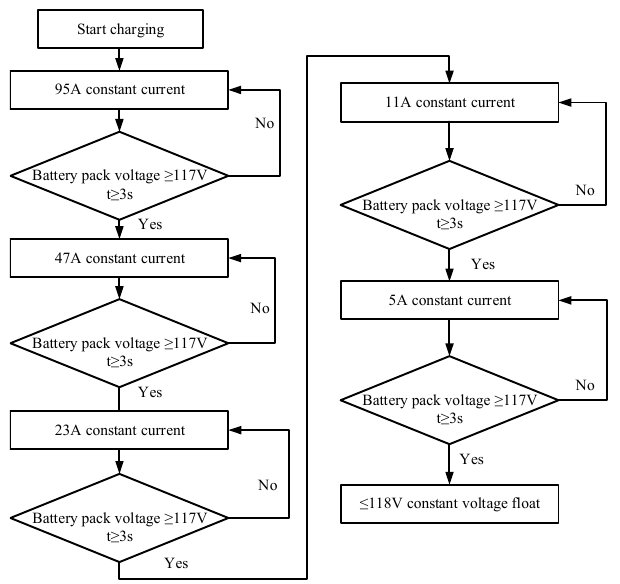
Figure 11. Standard EMU battery pack charging flow chart.